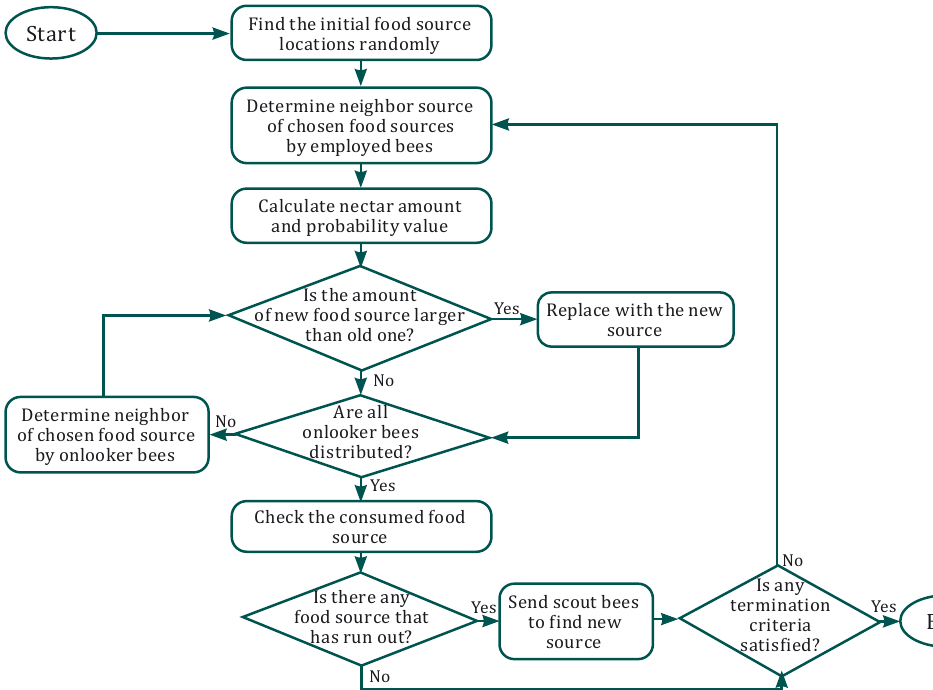
Figure 6. The flow chart of the used ABC algorithm in the